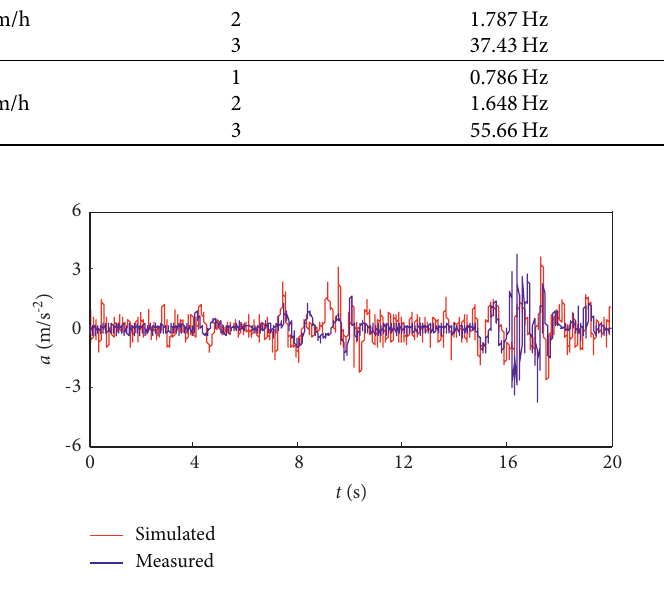
Figure 22: Vibration signal when passing through obstacle platform.